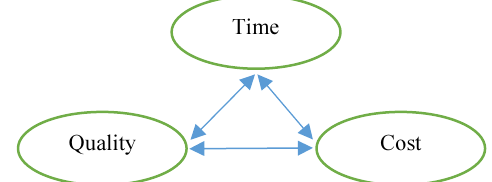
Fig. 2. Depicted network of interactions based on W r 2 in the criteria